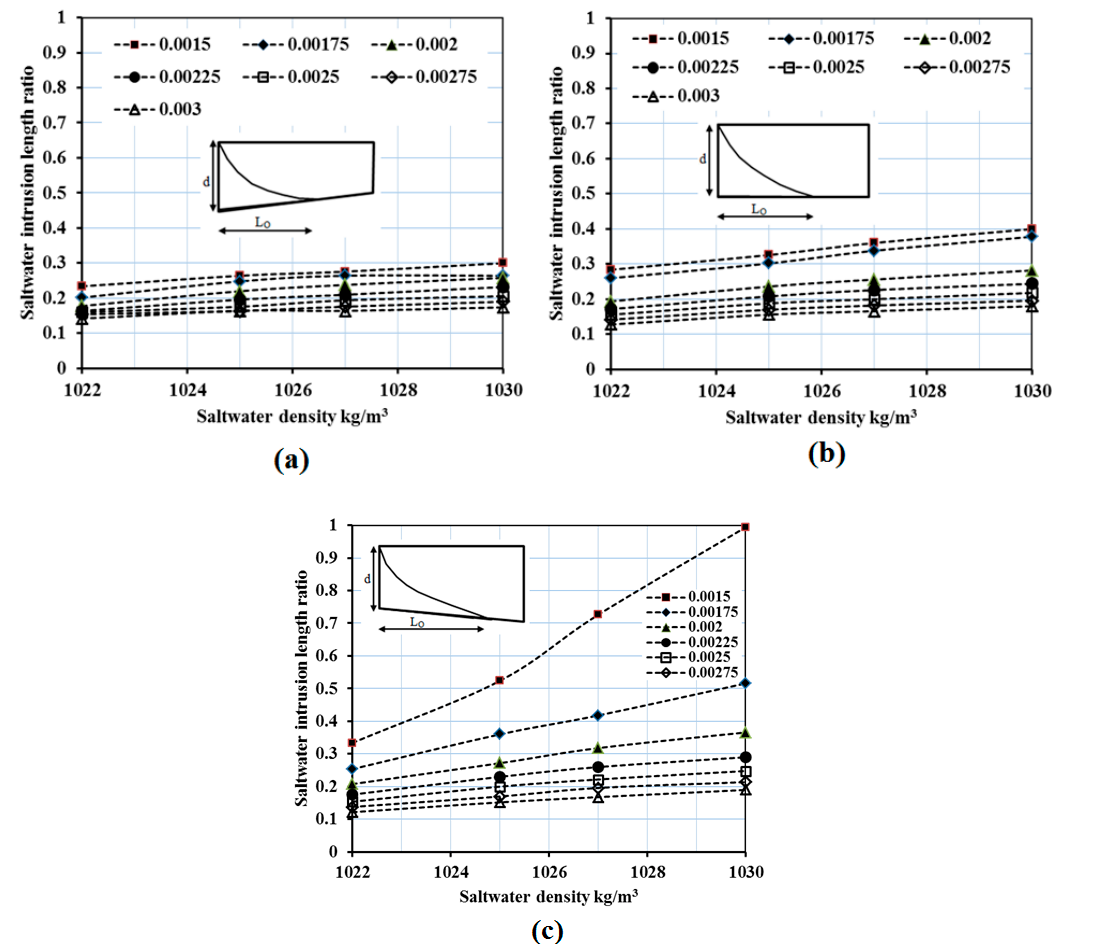
Figure 5. Relationship between saltwater density and SWI length ratio for ( a ) tan β = 0.02, ( b ) tan β = 0.0, and ( c ) tan β = − 0.02.